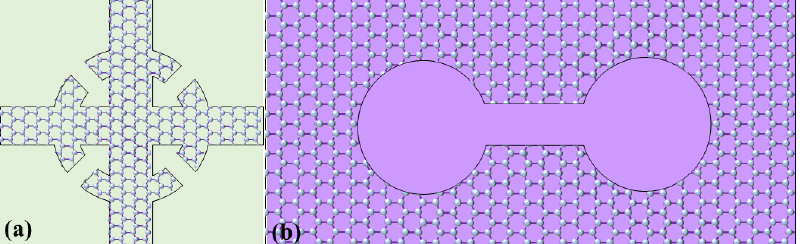
Figure 4. Graphene-based multi-band terahertz metamaterial absorbers using continuous graphene microstructures. ( a ) Graphene crossing and graphene ring with four gaps [54]; ( b ) dumbbell-shaped structure graphene [55].